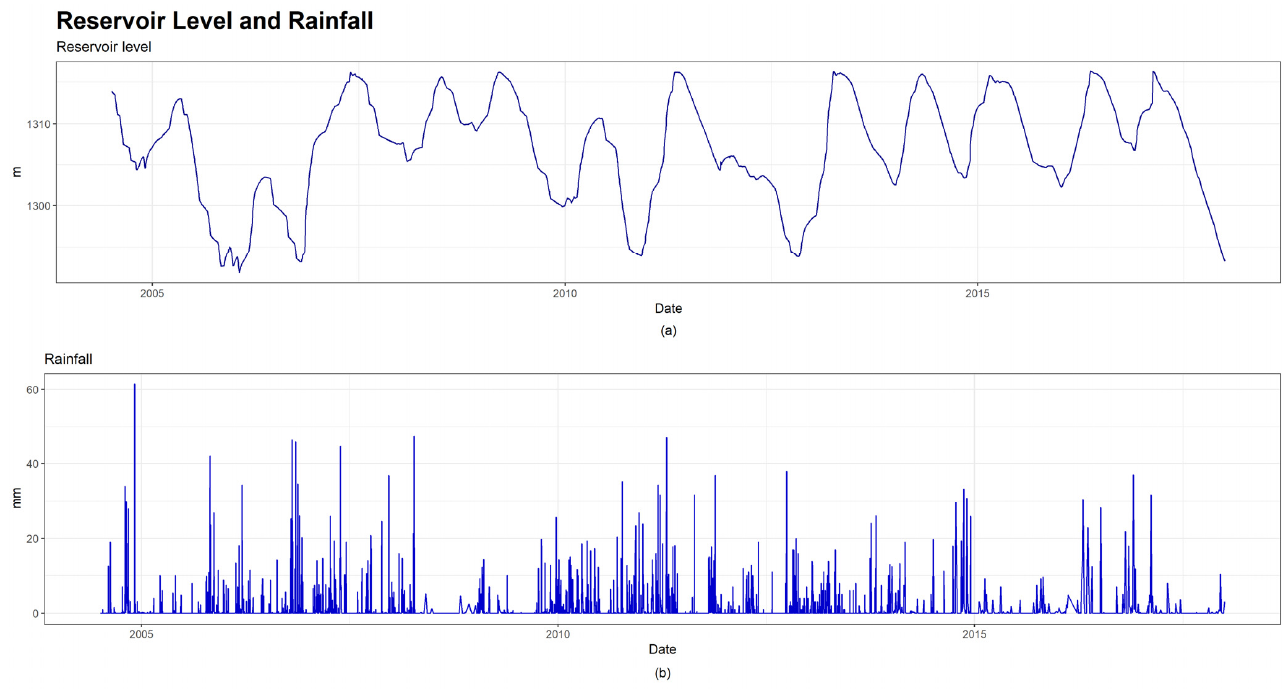
Figure 8. Series of reservoir level and rainfall. ( a ) Series of reservoir level; ( b ) Series of rainfall.